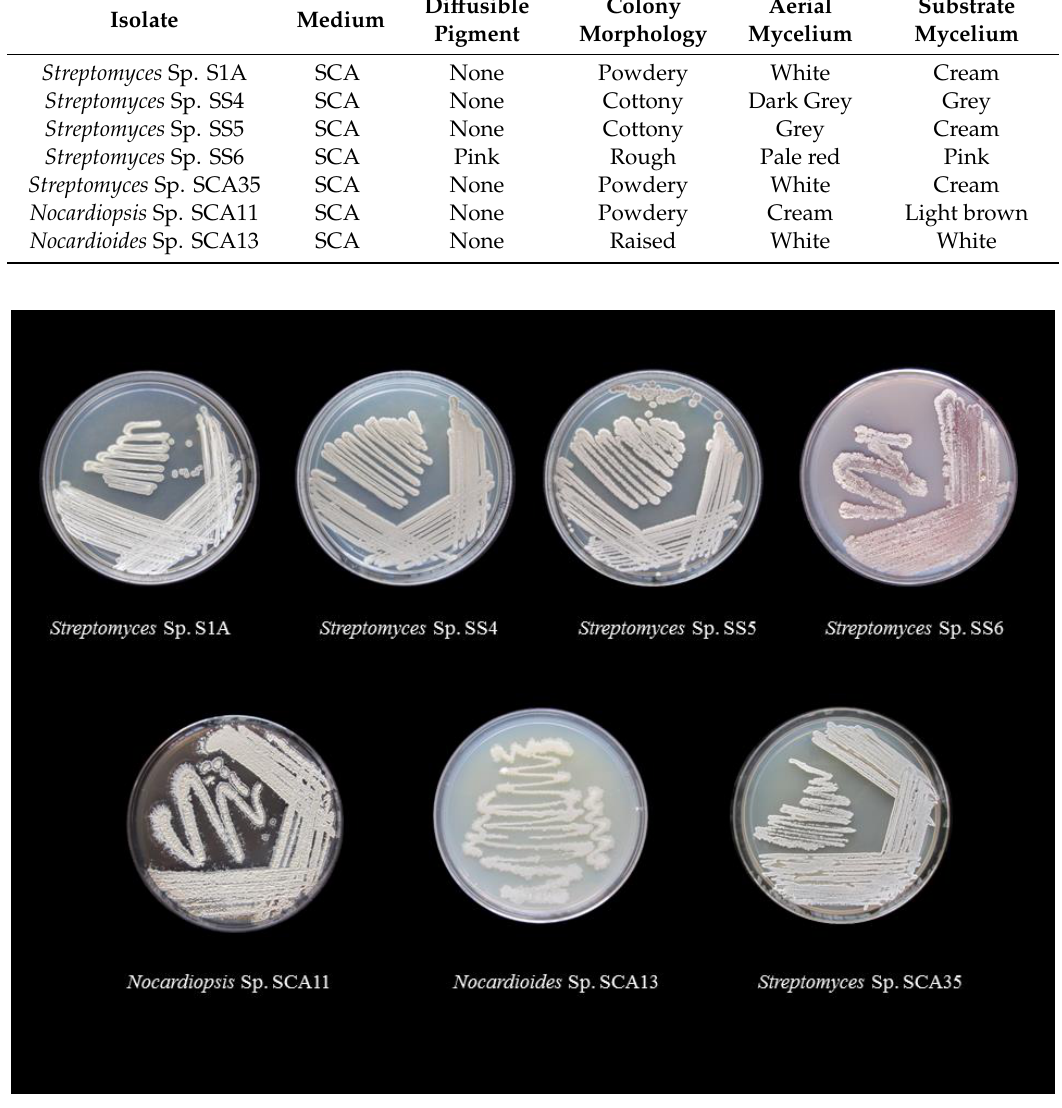
Figure 1. Morphological characterization of actinobacterial isolates on starch casein agar plates. Table 3. Molecular identification (based on 16S rRNA amplification) of actinobacterial strains isolated from Western